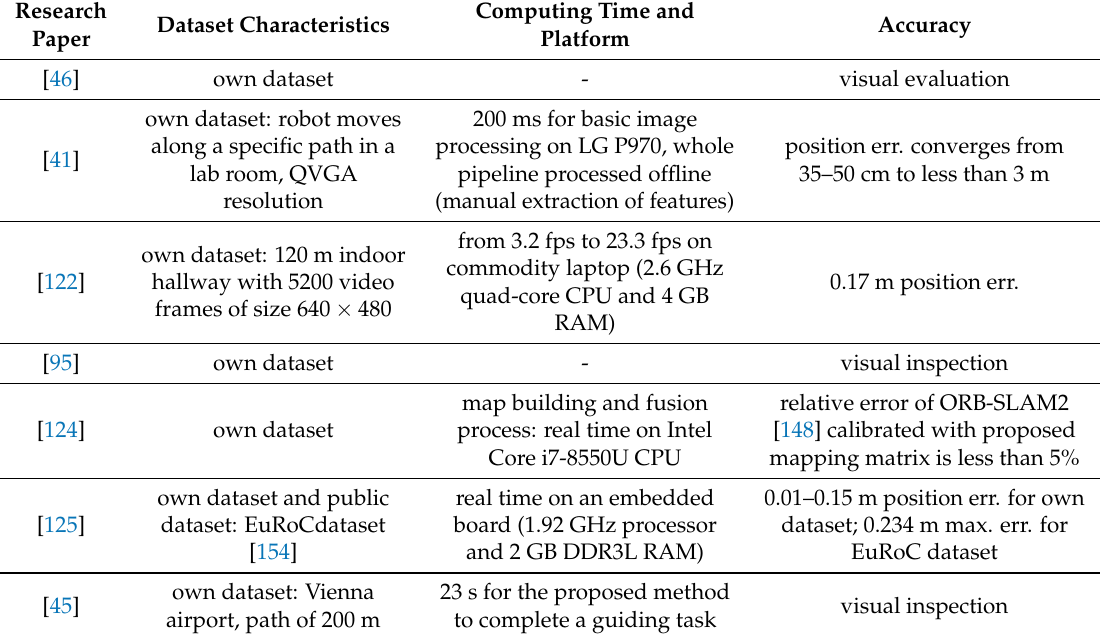
Table 18. Characteristics of indoor localization solutions with an existing/generated 3D model of the environment, 2D mobile cameras + other sensors, real features, and traditional image